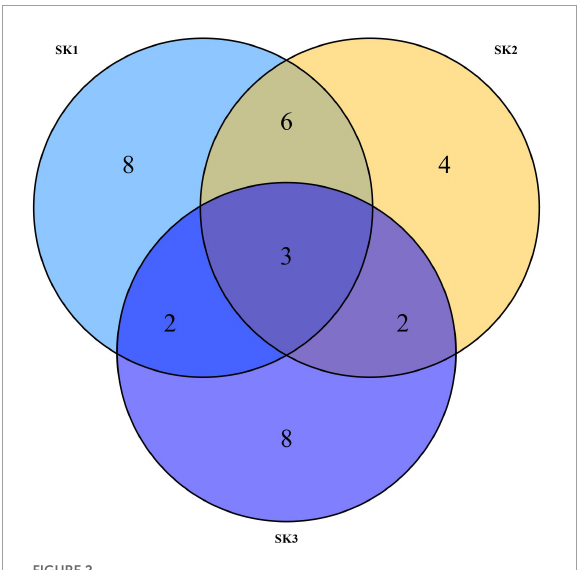
FIGURE2 Venn diagrams of three Melophagus ovinus samples based on OTUs.